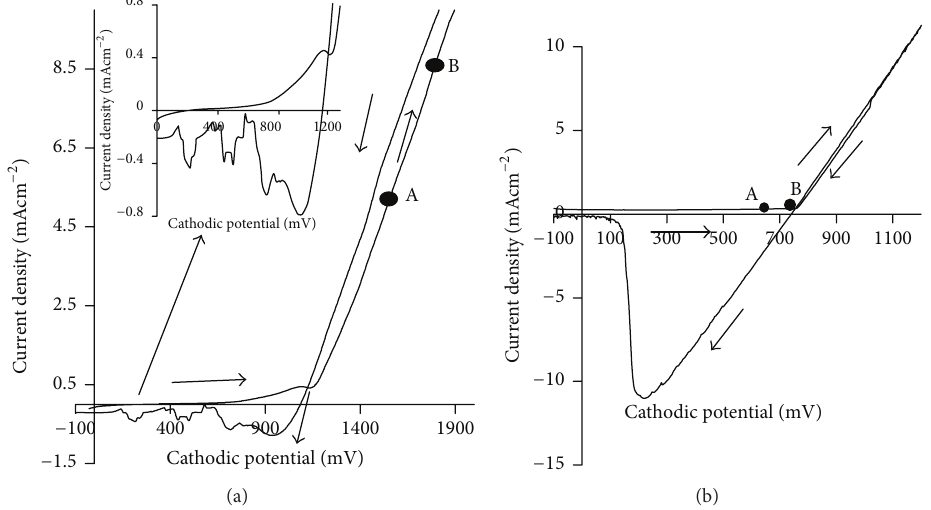
Figure 1: Cyclic voltammograms of CdTe deposition electrolytes for (a) two-electrode system and (b) three-electrode system.